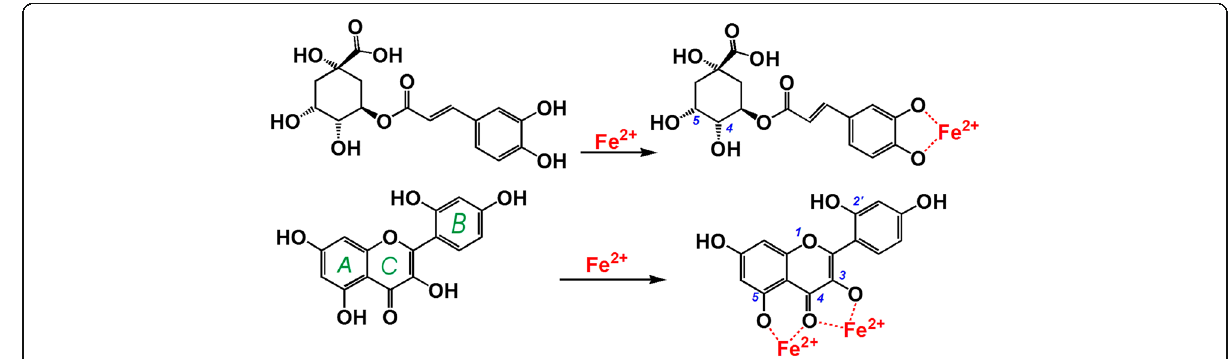
Fig. 7 The proposed reaction of Fe 2+ -chelating with chlorogenic acid ( a ), and with morin ( b )